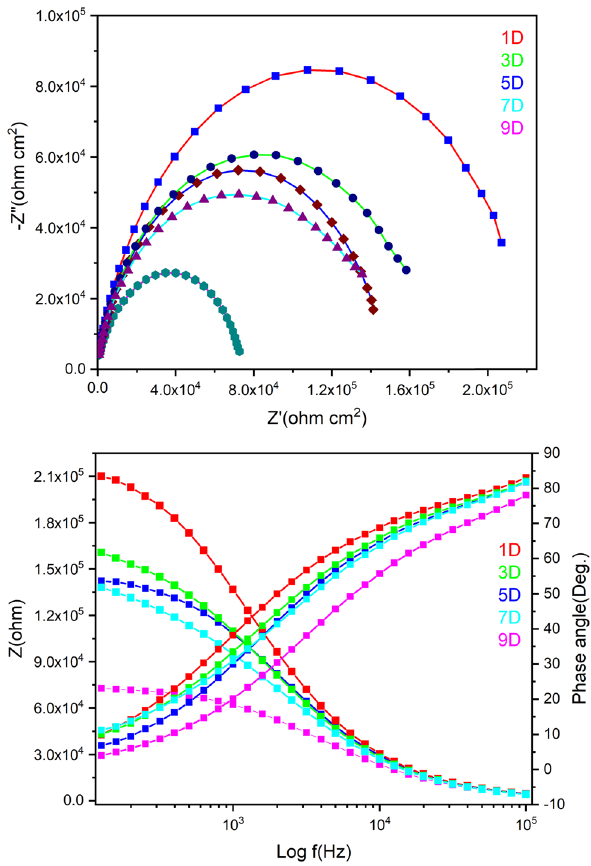
Figure 6: ( a ) EIS spectra of ROGAU - coated CS and ( b ) Bodetheta plot of ROGAU - coated CS.